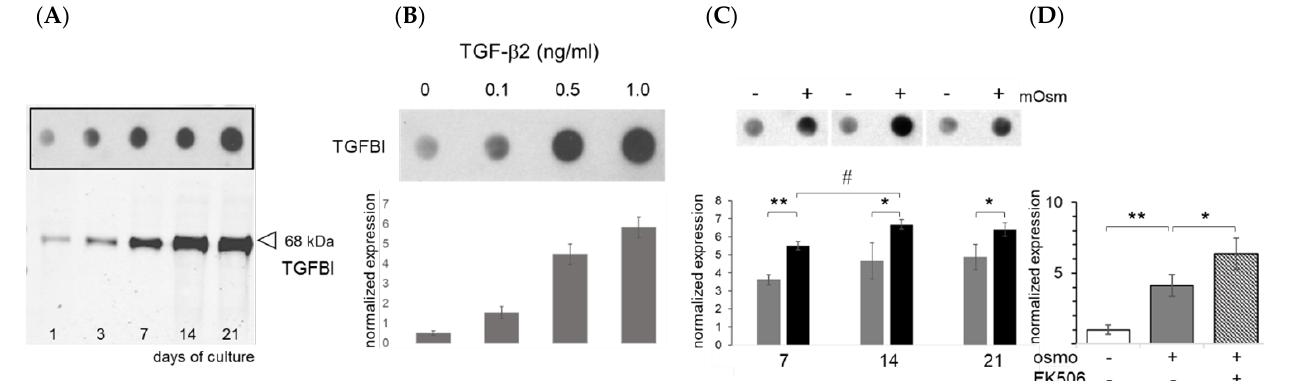
Figure 6. Expression of Transforming Growth Factor Beta Induced (TGFBI) protein. ( A ) Representa- tive correlation of TGFBI expression during ATDC5 differentiation as dot blots and Western blotting (n = 2). ( B ) TGF- β -dependence of TGFBI protein expression at baseline and ( C ) its inducibility by osmolarity is shown (n = 3). ( D ) FK506-dependence of relative TGFBI mRNA expression (day 10, n = 5). − , plasma level osmolarity; +, +100 mOsm/kg; *, p < 0.05; **, p < 0.01; #, inter-day p < 0.05. In line with earlier reports that increased osmolarity improves the secretion of TGF- β ligands in chondrocytes and chondrocytic cells from different species [38], physosmotic culture conditions (+100 mOsm/kg) alone increased Col2a1 mRNA expression (Figure 7A).